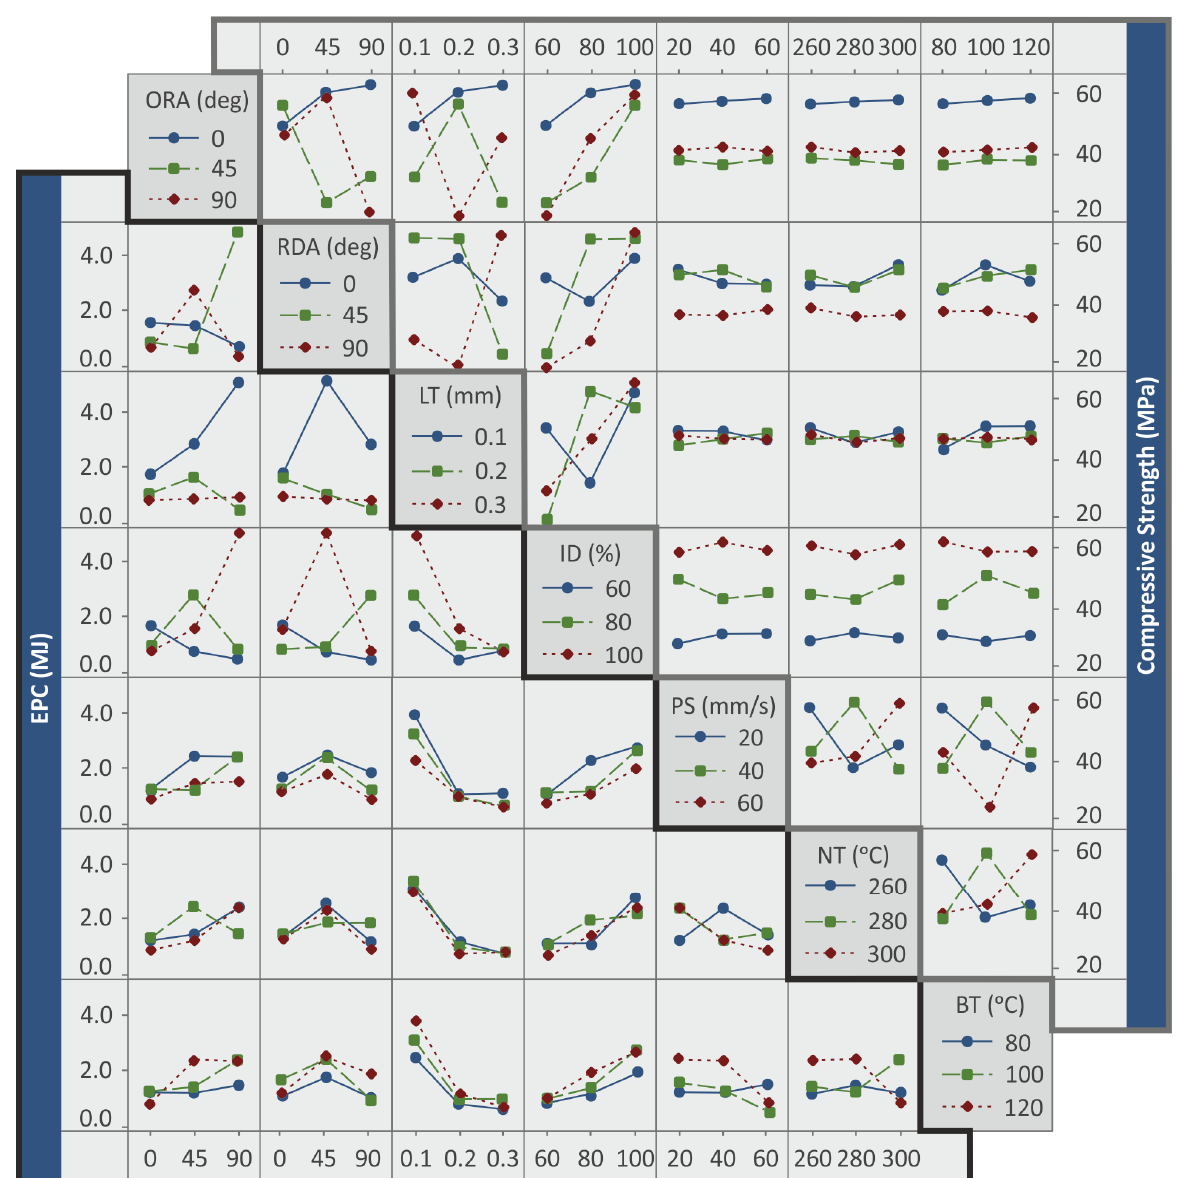
Figure 10. Interaction plots for the energy (MJ) and the compressive strength (MPa) vs. the control parameters of this work.